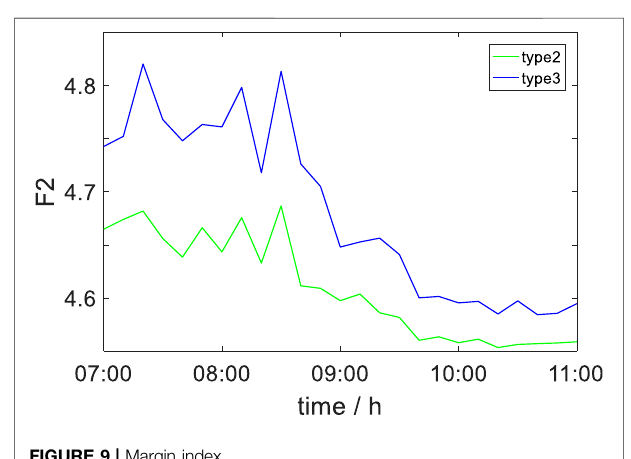
FIGURE 9 | Margin index.